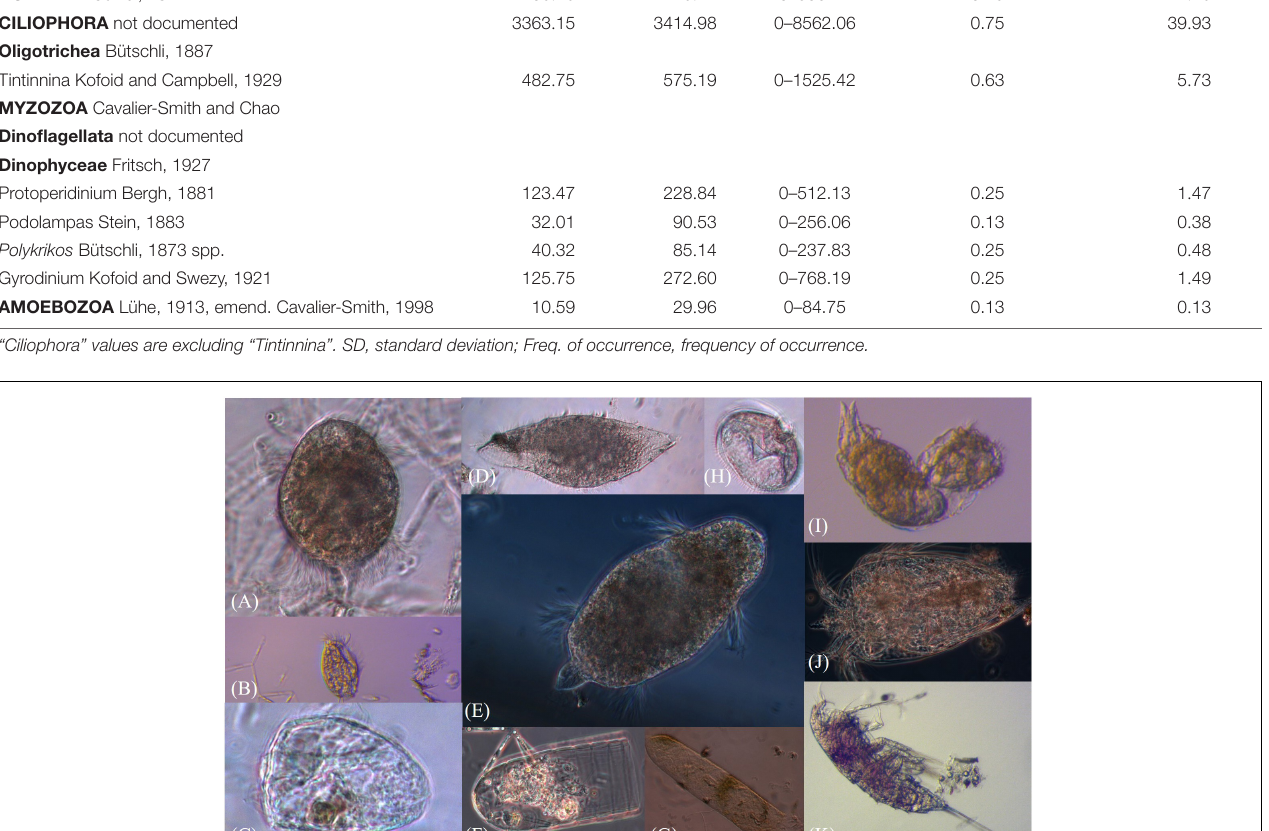
and the slope of the Sophia Basin sampled early during the expedition ( Figure 4 ). Those stations showed also a higher abundance of Ciliophora compared to the offshore stations (stations 39–47). The NMDS ordination of the sampling